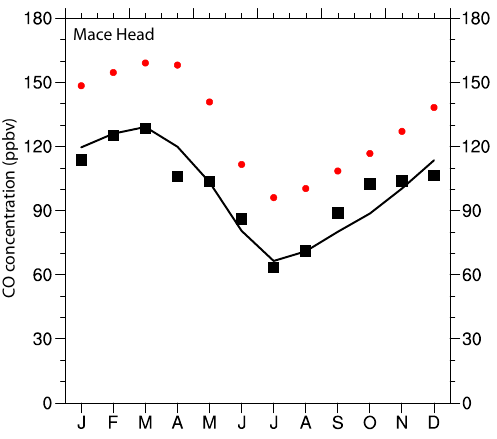
Fig. 8. Time evolution (1960–2009) of surface CO (12-month run- ning mean) at Mace Head. Observations are in red, CAM-chem results are in black (solid line) and GPUCCINI results are in black (solid squares). A constant value of 25ppbv was subtracted from the observations to take into account model deficiencies; this is shown as green